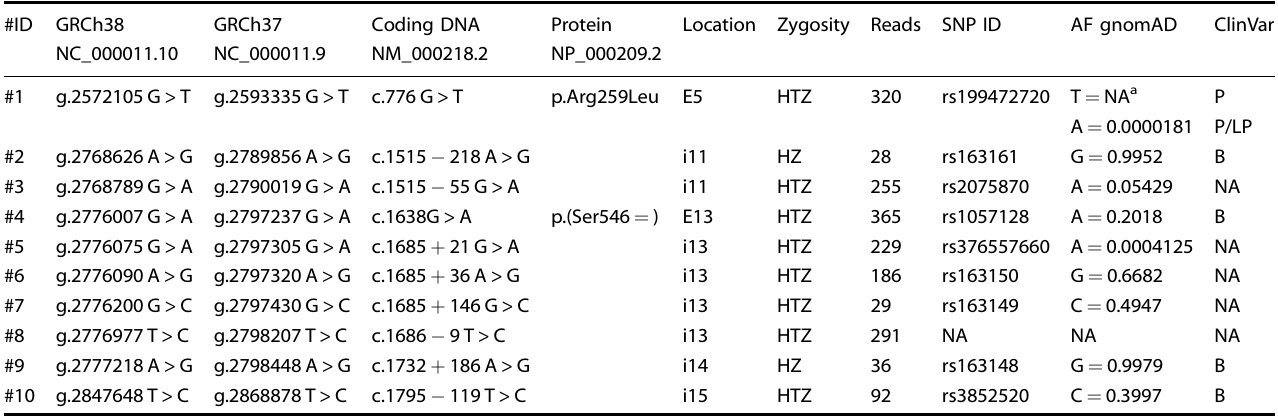
Table 1. Identi fi ed KCNQ1 variants using targeted